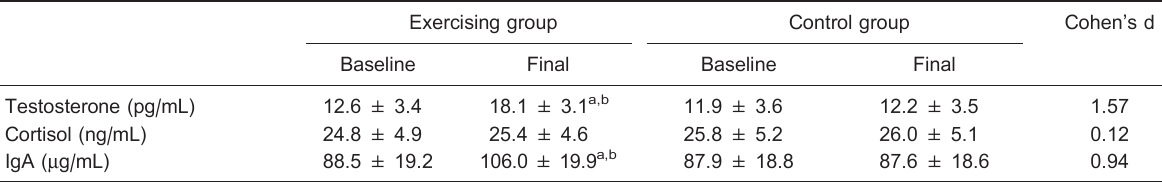
Table 2. Effects of resistance training on salivary hormones (testosterone, cortisol) and immunoglobulin A (IgA) levels in sedentary male adults with Down